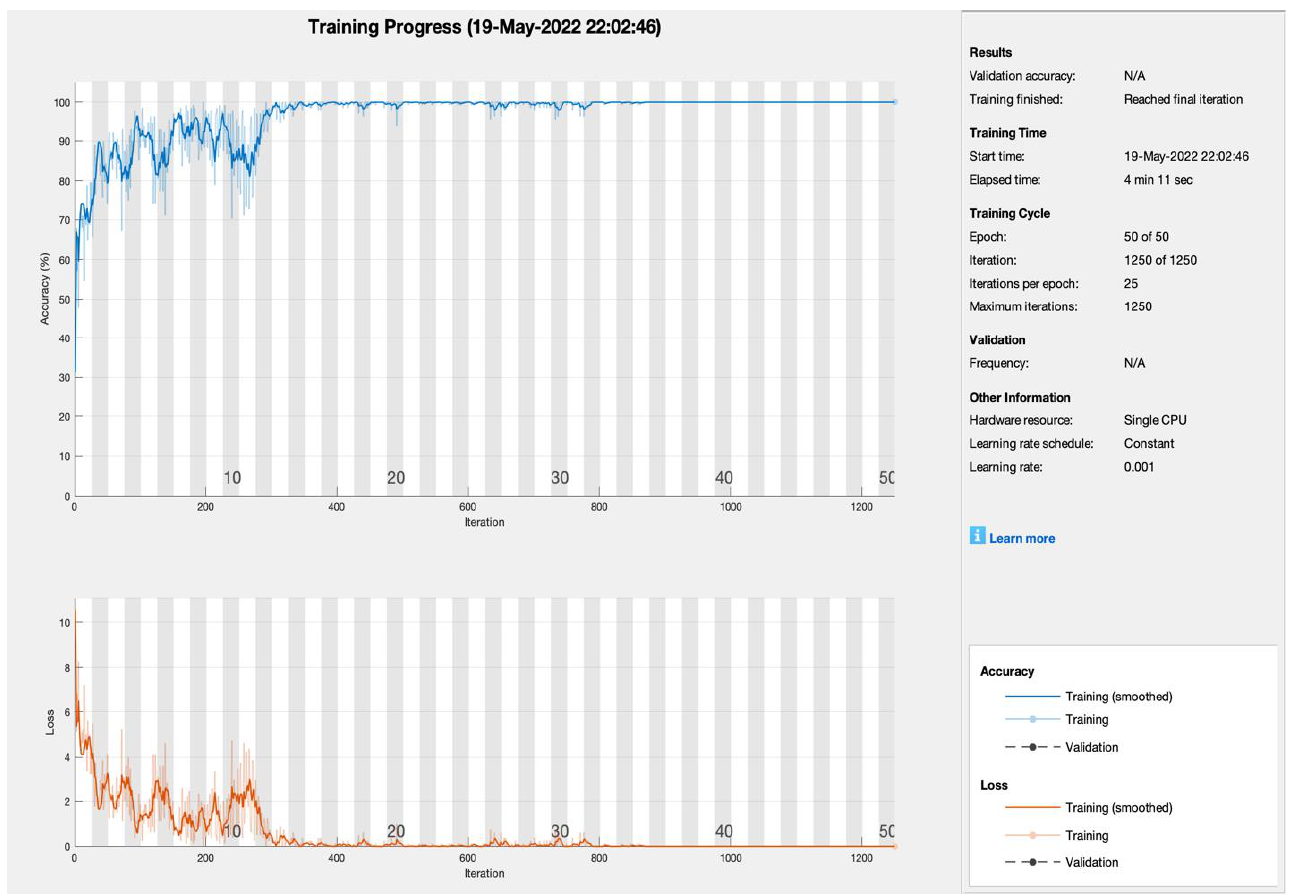
Figure 3. Training progress of SGDM empowered with blockchain, edge computing, and fog computing.